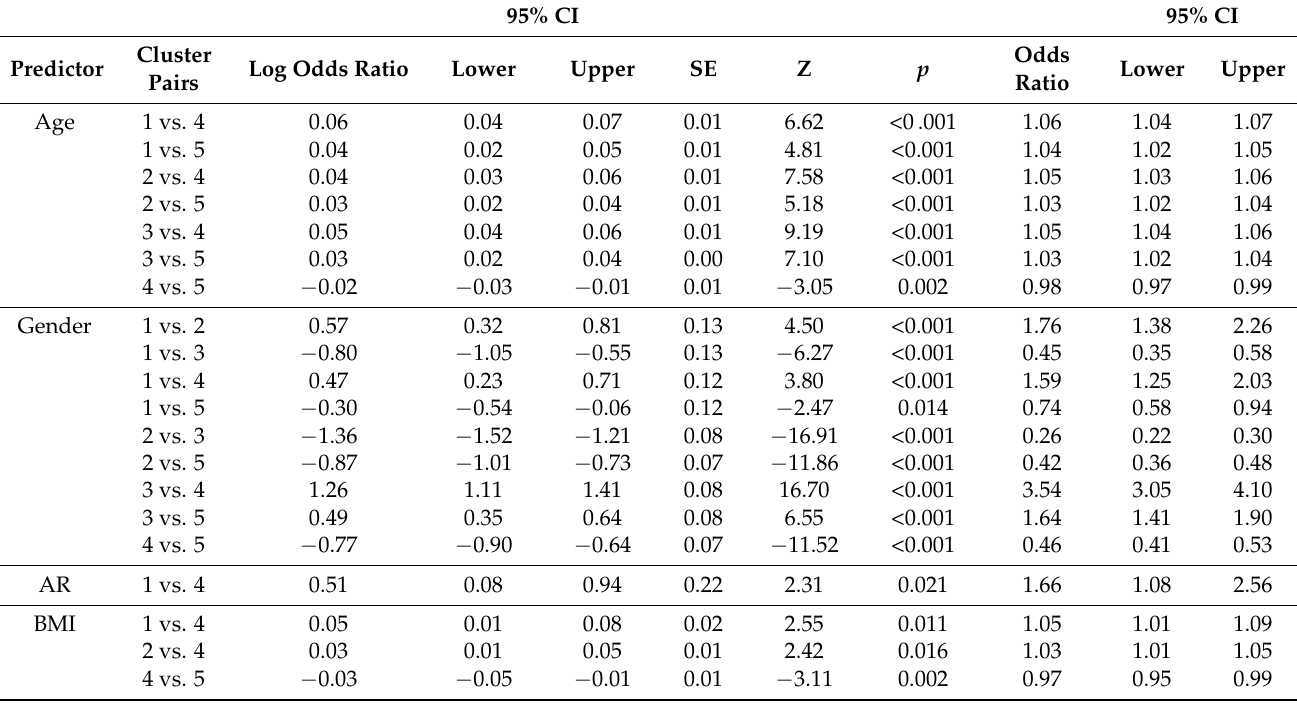
Table 5. Multinomial logistic regression results.